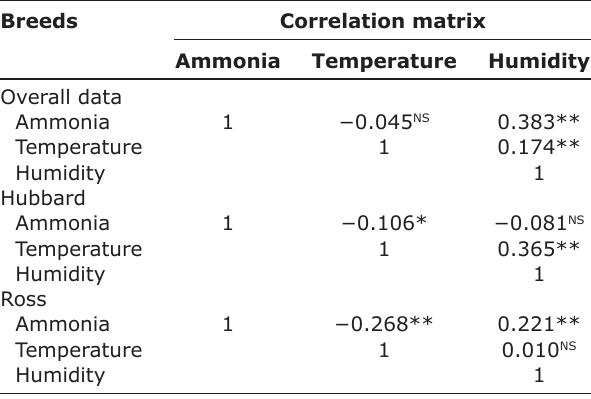
Table-3: Pearson’s correlation coefficients between ammonia, temperature and humidity for Hubbard, Ross and both